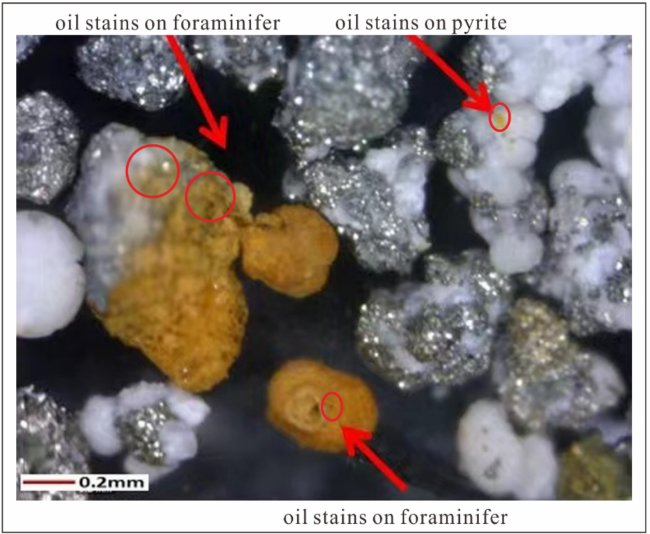
Figure 2. Oil stains in sample 2 from core GMGS4-XH-W03B. Red arrows reflect the direction indicated by the comment text; red circles suggest the locations of oil